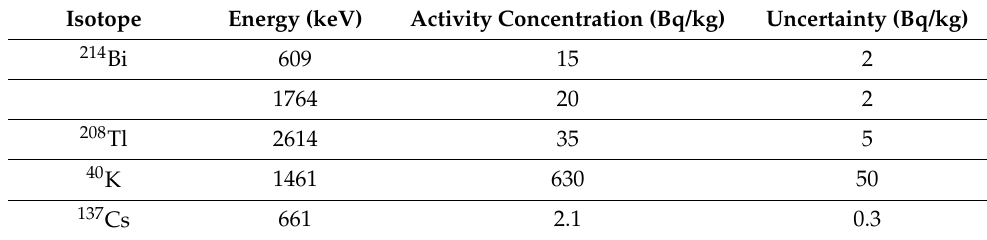
Table 2. The measured quantitative data in the sediment using the KATERINA detection